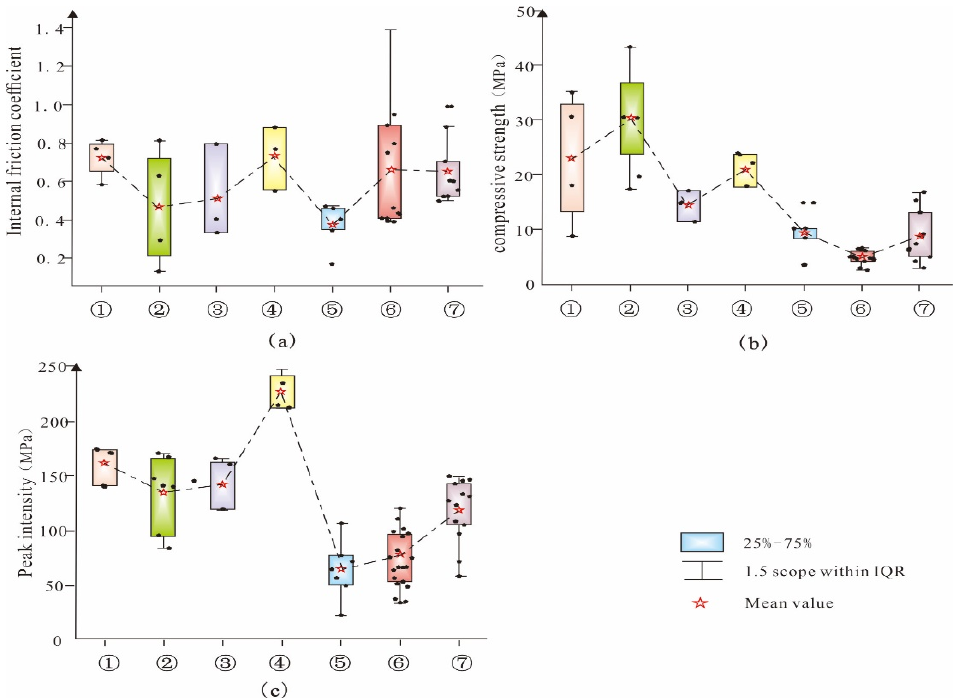
Figure 6. Comparison diagram of lithology and mechanical properties: ( a ) coefficient of internal friction, ( b ) compressive strength, ( c ) peak intensity. 1 (cid:13) = gypsum dolomite, 2 (cid:13) = micritic